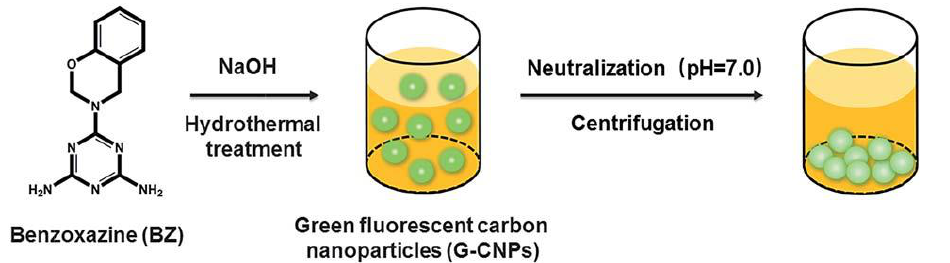
Figure 50. Synthesis schematic of basophilic green fluorescent carbon nanoparticles derived from benzoxazine (reproduced from the work in [119] with permission).